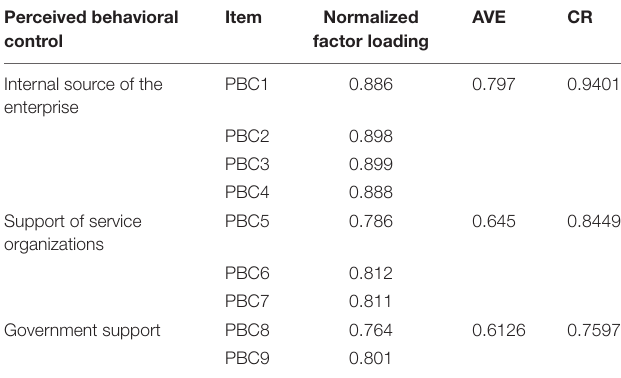
TABLE 6 | Convergence validity test results of the perceived behavioral control in